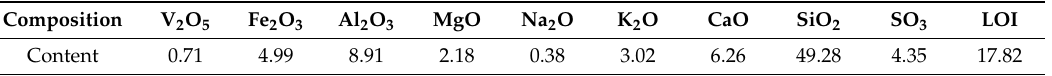
Table 1. Chemical composition of vanadium-bearing shale wt